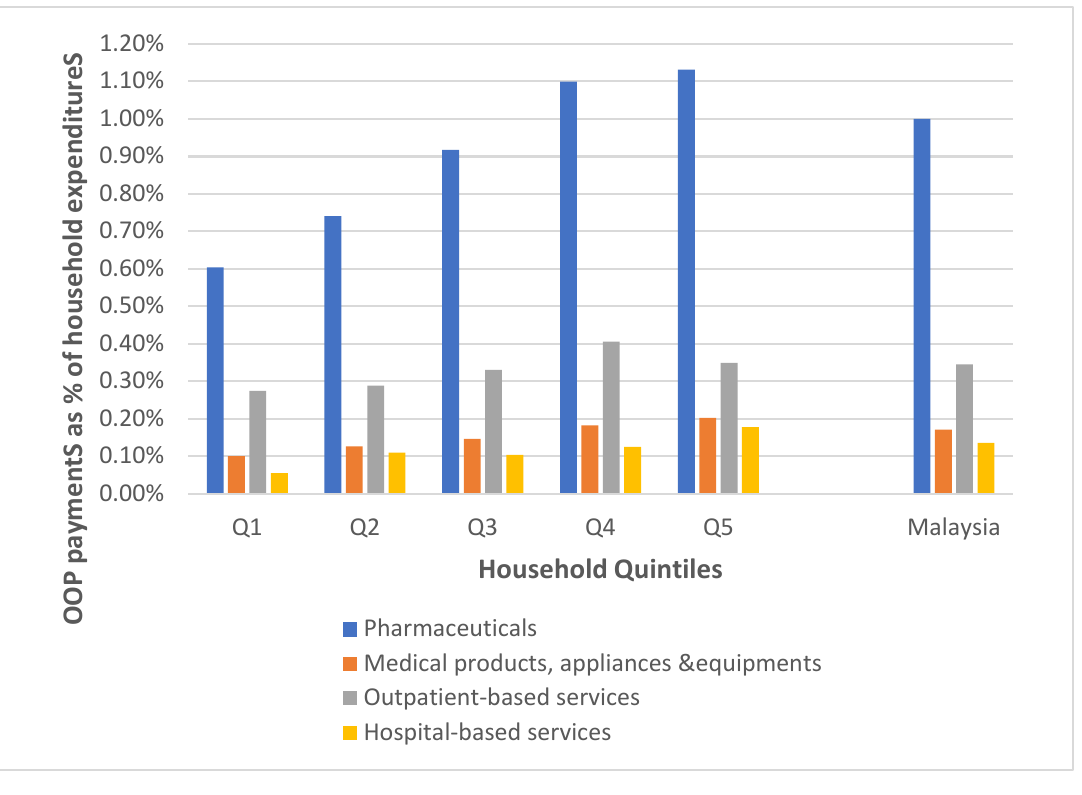
Figure 4. Proportion of OOP health payments from household consumption by groups of healthcare services, Malaysia 2014/2015. Table 4. Gini coefficient, concentration index and Kakwani Progressivity Index for OOP payments for healthcare by groups of healthcare services, Malaysia